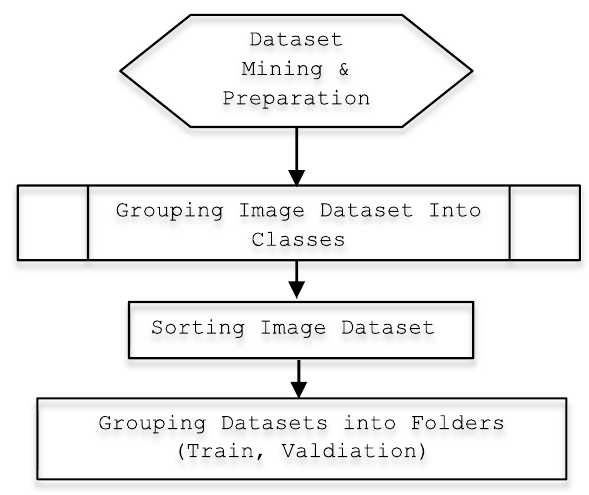
Figure 6: Flow chart of dataset making